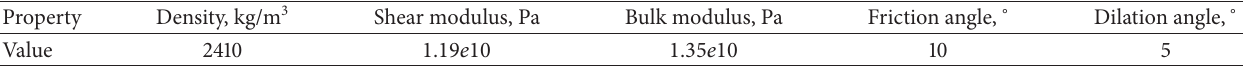
Table 3: Input parameters for the double yield model.